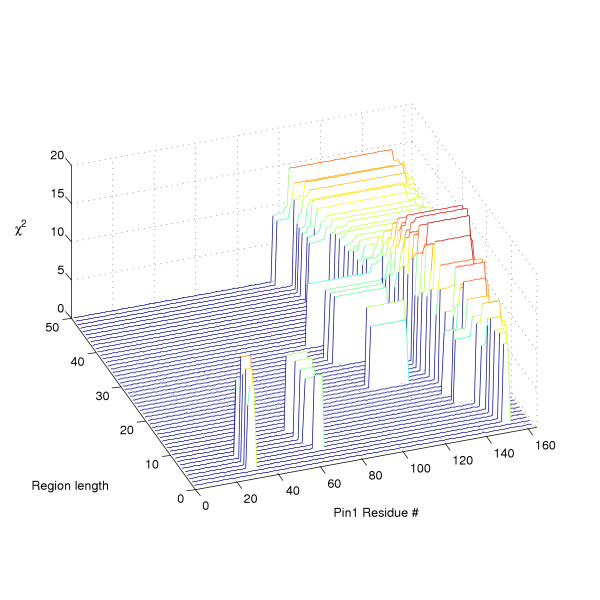
Region-independent chi-square analysis. Three-dimensional plot illustrating χ2 of each significantly hypomutable region plotted against region length and amino acid residue number. Calculations were performed as described in the text. Only regions that are significant at the 0.005 level are plotted; the whole window is plotted whenever this significance level is achieved. If a residue is involved in more than one significant region of the same length, the region with the highest χ2 value is plotted. Colours indicate χ2 of the region and range from deep red (χ2 > 15, corresponding to α < 0.0001) to pale green (χ2 > 8, α < 0.005). Four hypomutable regions approximating regions A-D (Figure 1) are evident.